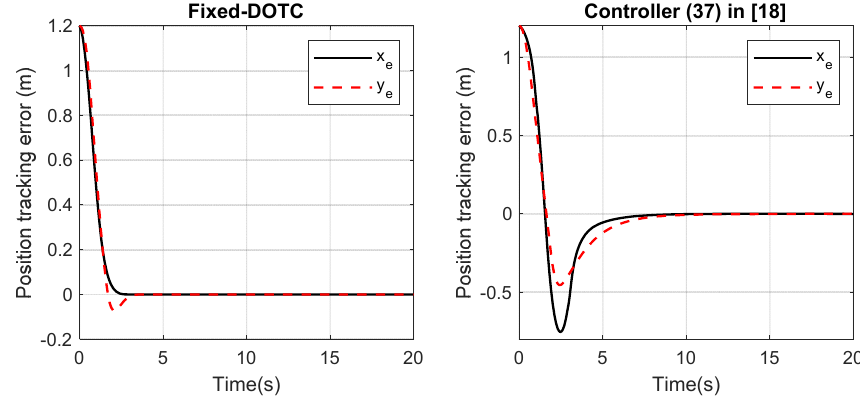
Figure 10. The position tracking errors in part 2.